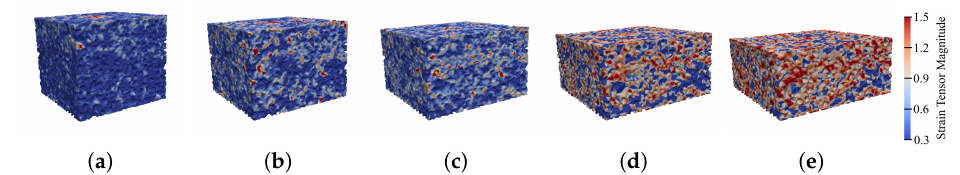
Figure 11. The micro-strain contour evolution during the compaction process of specimen S 3 , ( a ) (cid:101) 3 = 0.1, ( b ) (cid:101) 3 = 0.2, ( c ) (cid:101) 3 = 0.3, ( d ) (cid:101) 3 = 0.4, ( e ) (cid:101) 3 = 0.5.